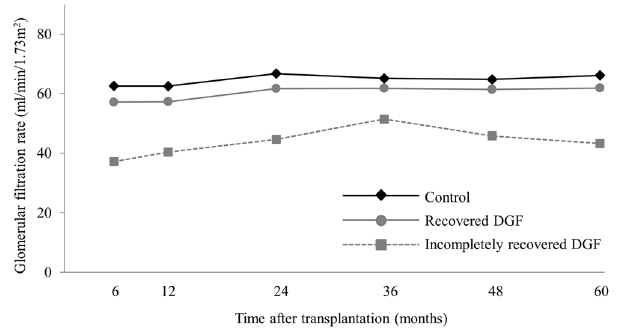
Figure 4. Renal function according to DGF recovery status.